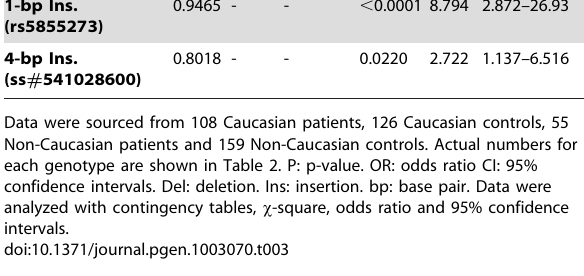
each genotype are shown in Table 2. P: p-value. OR: odds ratio CI: 95% confidence intervals. Del: deletion. Ins: insertion. bp: base pair. Data were analyzed with contingency tables, x -square, odds ratio and 95% confidence